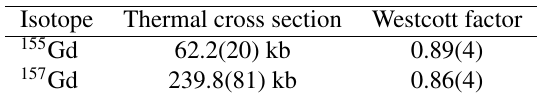
Table 3. Capture cross section and Westcott factor deduced from the n_TOF